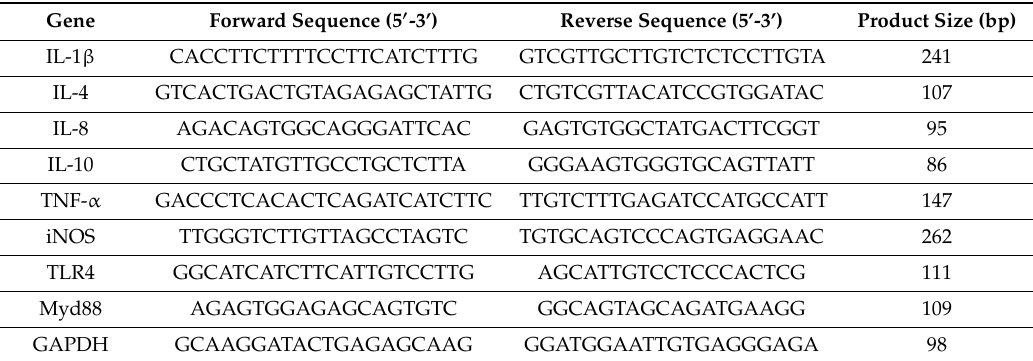
Table 2. Sequences of PCR